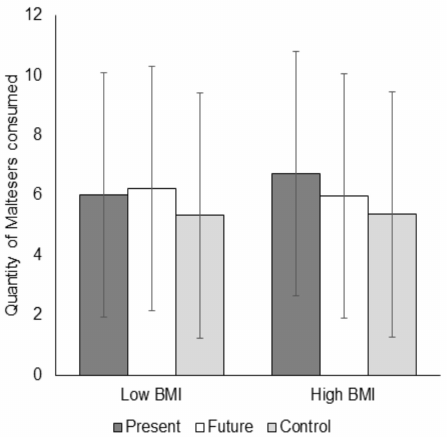
Figure 2. Quantity of Maltesers consumed at low (1 SD below the mean) and high (1 SD above the mean) levels of BMI for each condition in Experiment 2. The error bars represent the prediction